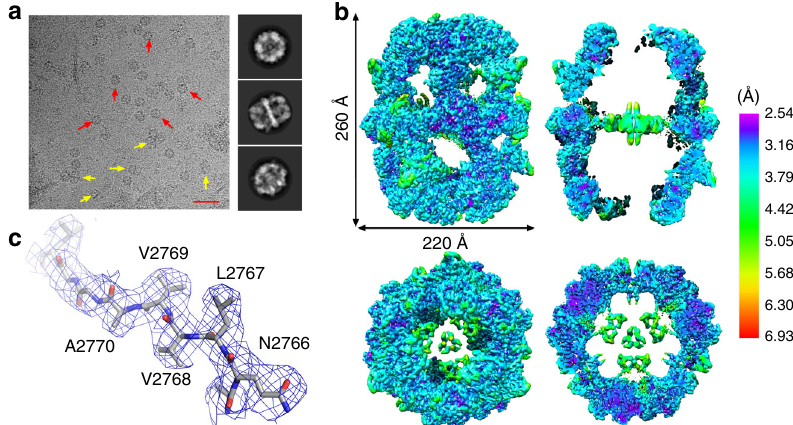
Fig. 1 Determining a 3.3 Å resolution map using single particle cryo-EM. a Cryo-EM micrograph of Mtb FAS-I particles. FAS-I particles are clearly visible in the micrographs. Scale bar represents 50 nm. Red and yellow arrows highlight some particles with ‘ top ’ or ‘ side ’ views, respectively. Representative 2D- class averages of ‘ top ’ , ‘ side ’ , and ‘ tilted ’ views are shown on the right side of the micrograph from top to bottom, respectively. b Electron density map of FAS-I colored by the local resolution estimate. Resolution lower than 3.0 Å is colored purple/blue, between 3.0 and 5.0 Å is colored cyan/green and higher than 5.0 Å is colored in yellow/red. ‘ Side ’ views (upper images) and ‘ top ’ views (lower images) of the density map are shown. The panels on the right are cross-sections of the map, illustrating the quality of density in the central regions of the map. c A segment spanning residues 2765 – 2773 of FAS-I illustrating the map quality at inner regions at better than 3.0 Å resolution